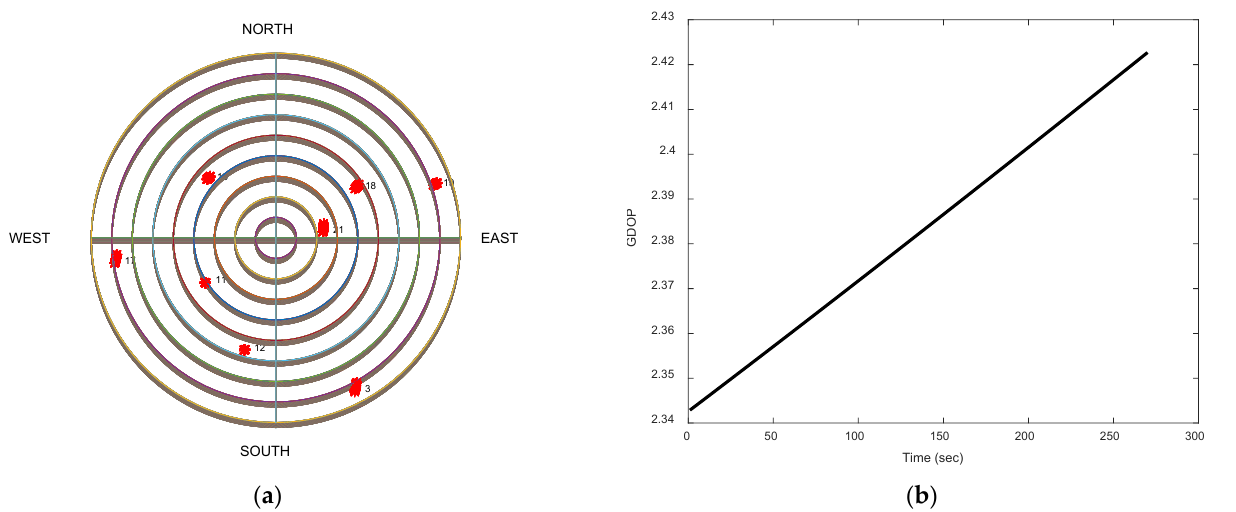
Figure 5. ( a ) The skyplot and ( b ) the GDOP during the simulation interval.